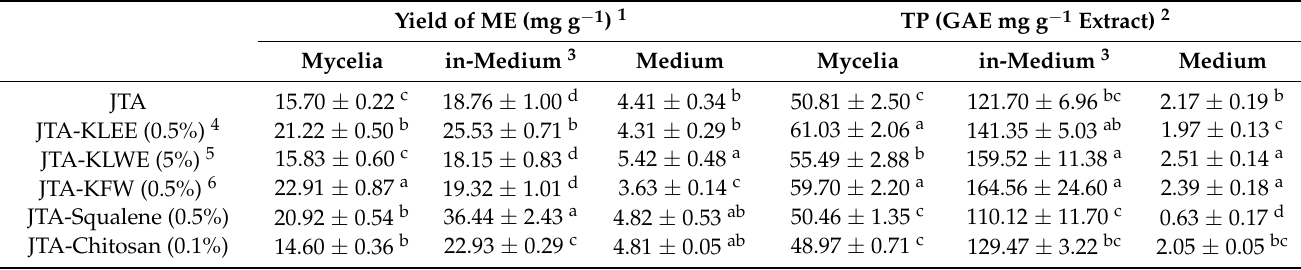
Figure 1. Growth curves for A. camphorata cultured on various media. Each value is expressed as the mean ± SD ( n = 3). Table 1. Yield and total phenyl compounds in the MEs from A. cinnamomea mycelia, inoculated medium (in-medium), and fresh